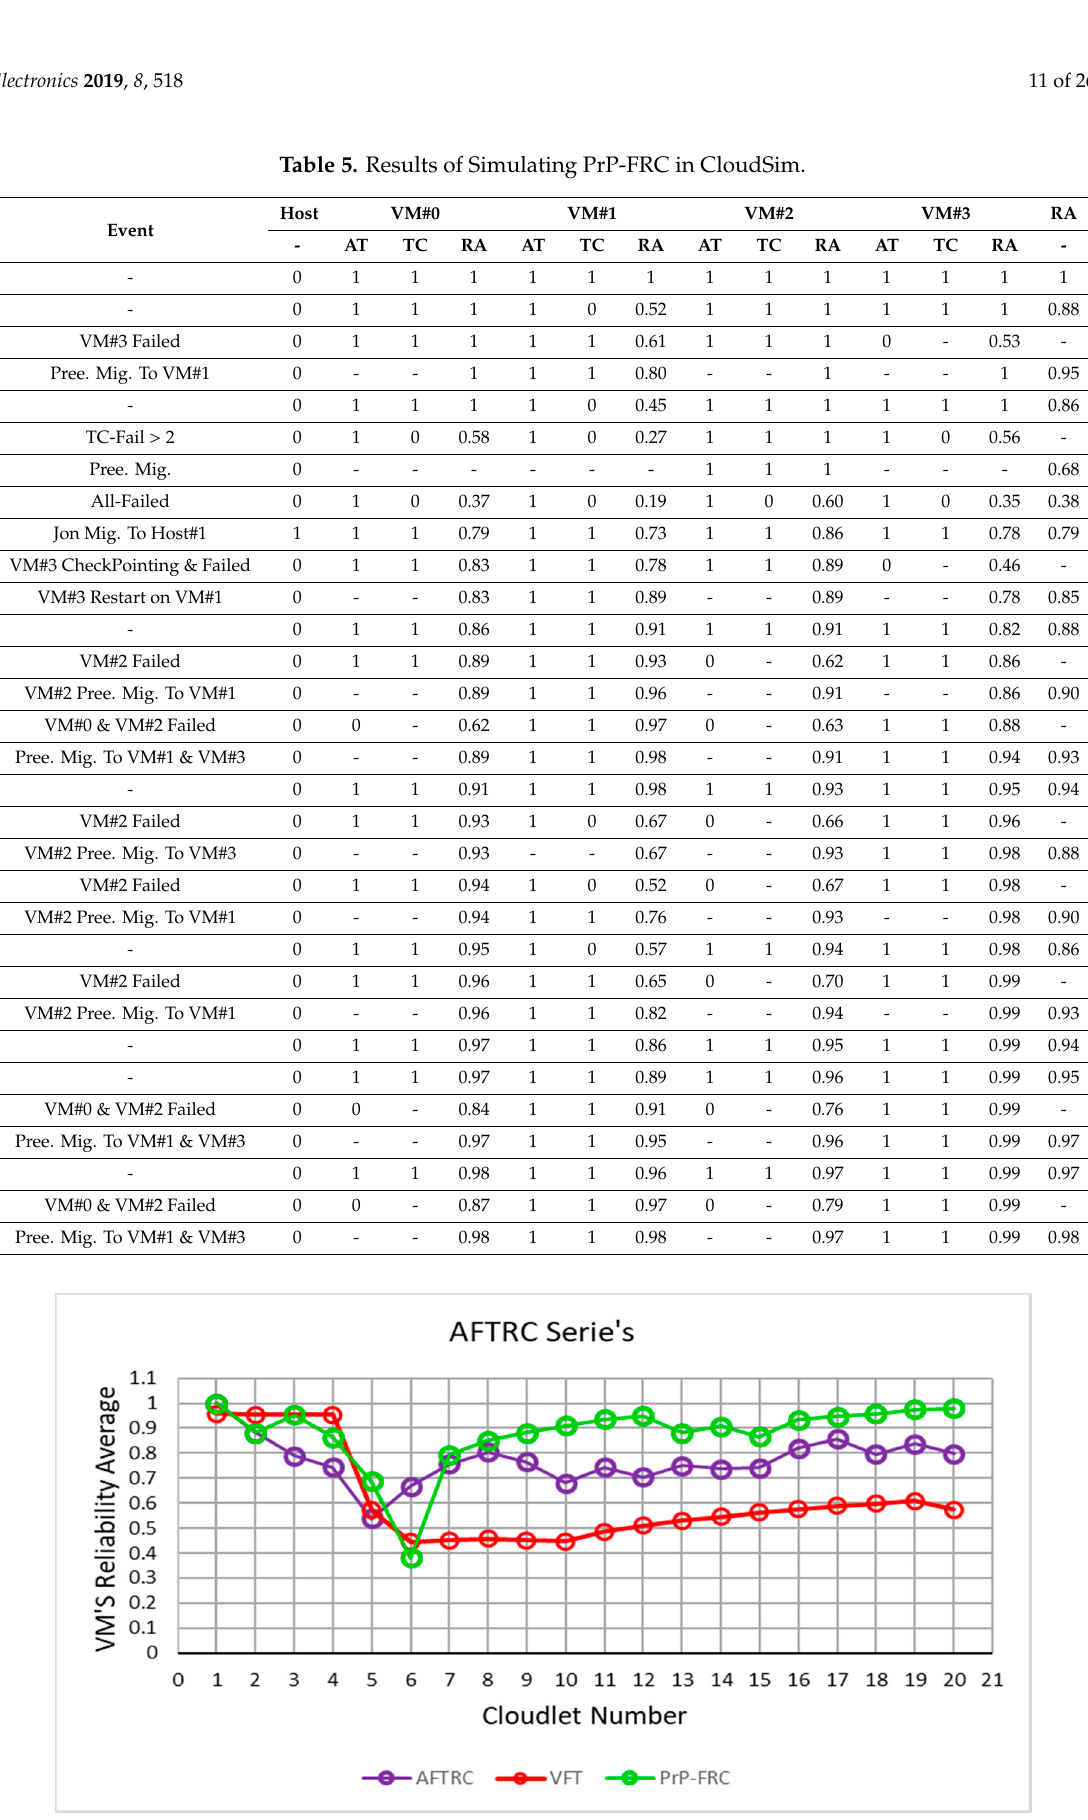
Figure 4. Comparison of Diagrams of Reliability of Architectures.